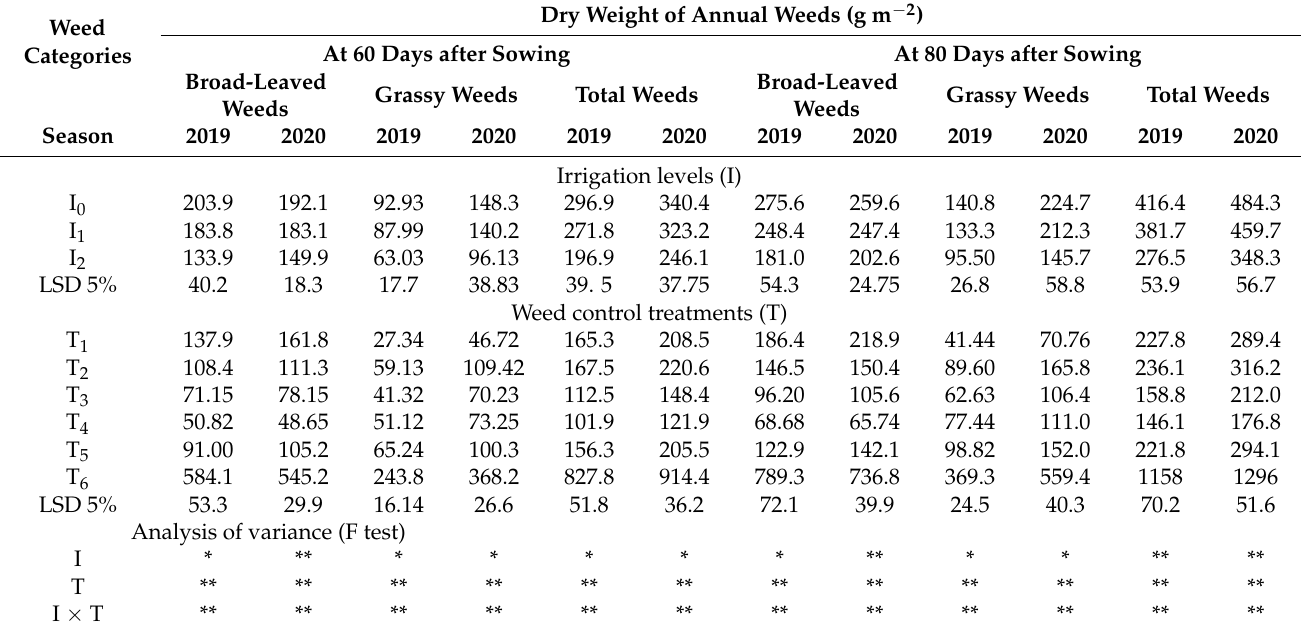
Table 7. Effect of irrigation levels and weed control treatments on dry weight of annual weeds (g m − 2 ) at 60 and 80 days after sowing in the 2019 and 2020